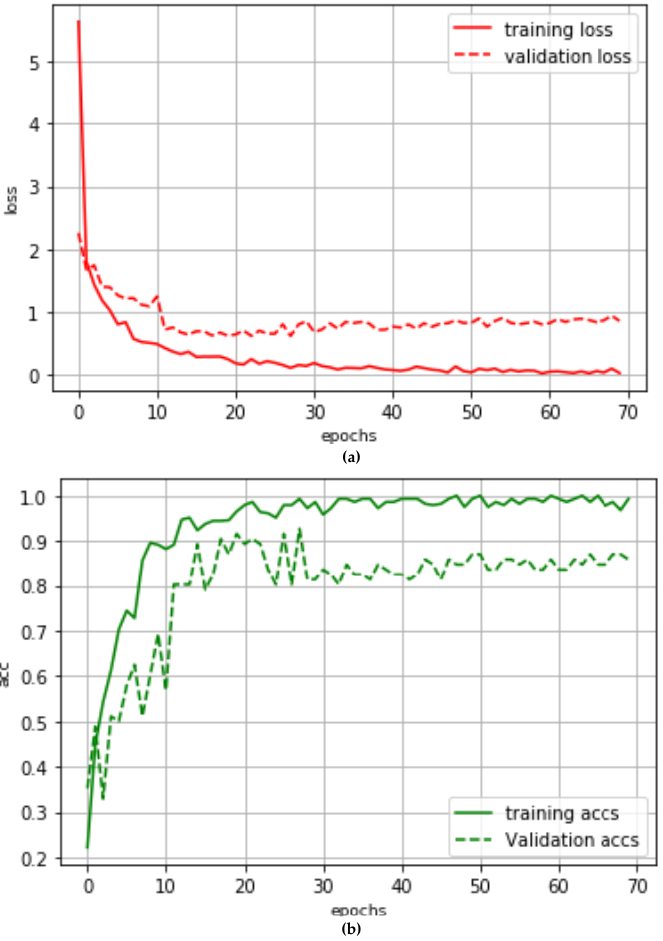
Figure 8. VGG training results of different batches for the State pattern classifier. ( a ) Loss Curve. ( b ) Acc Curve.